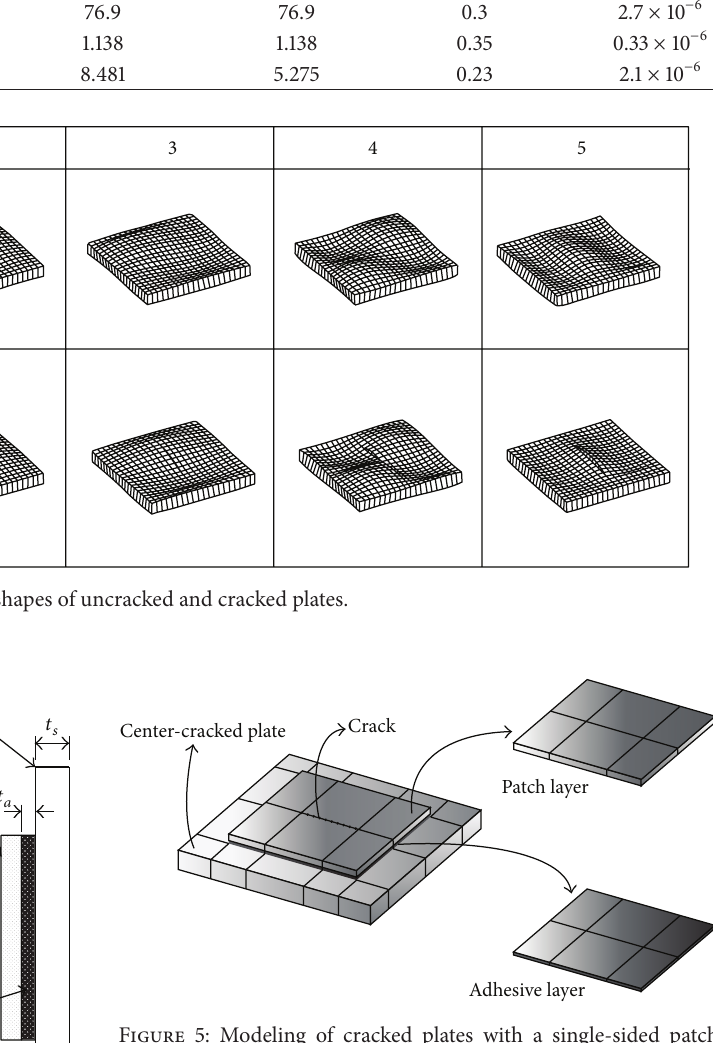
Figure 5: Modeling of cracked plates with a single-sided patch repair using present